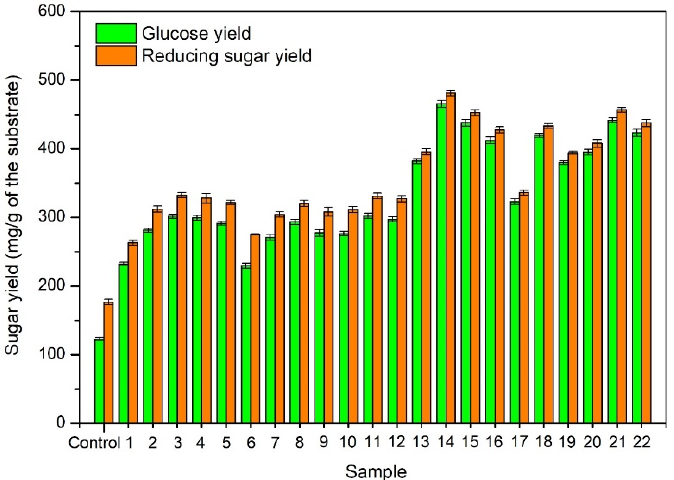
Figure 1. Glucose and reducing sugar yields of straw samples before and after LHW and LHW-PTA pretreatment.